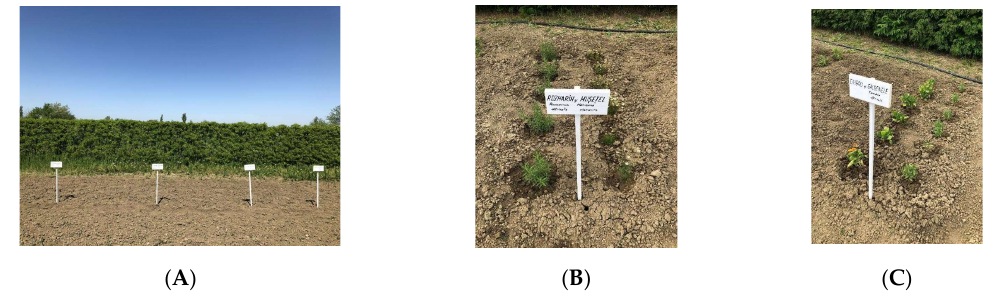
Figure 1. Developing the ground in two steps-place arrangement, 2018 ( A ), and planting the seedlings ( B , C ).